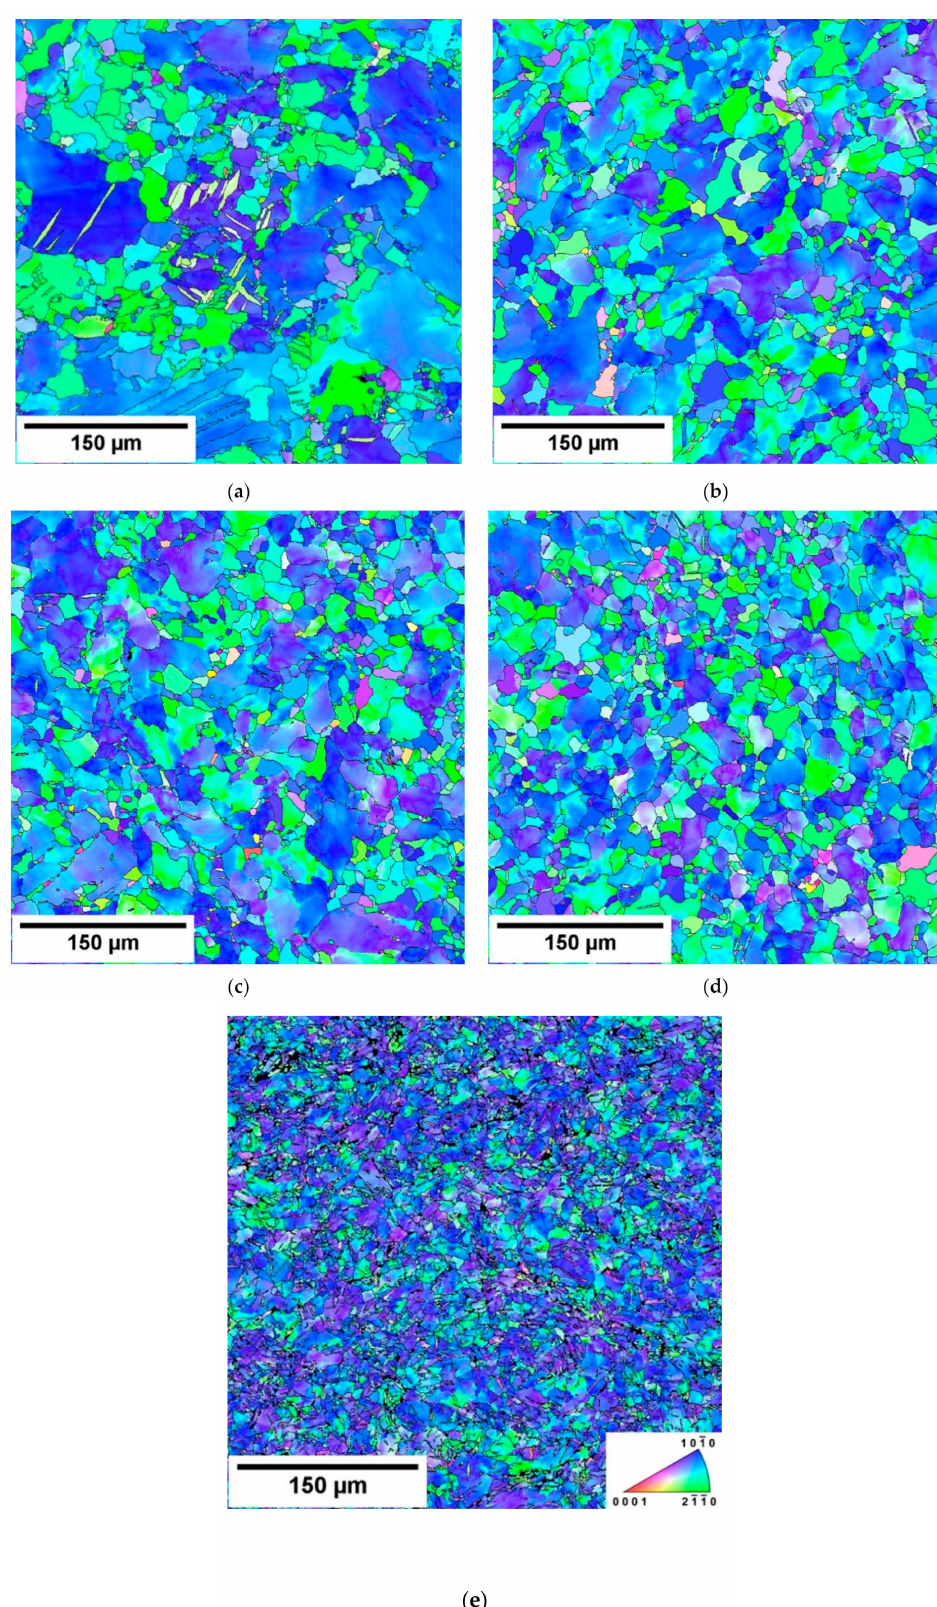
Figure 2. EBSD orientation maps: ( a ) SW1, ( b ) SW2, ( c ) SW3, ( d ) SW4 and ( e )